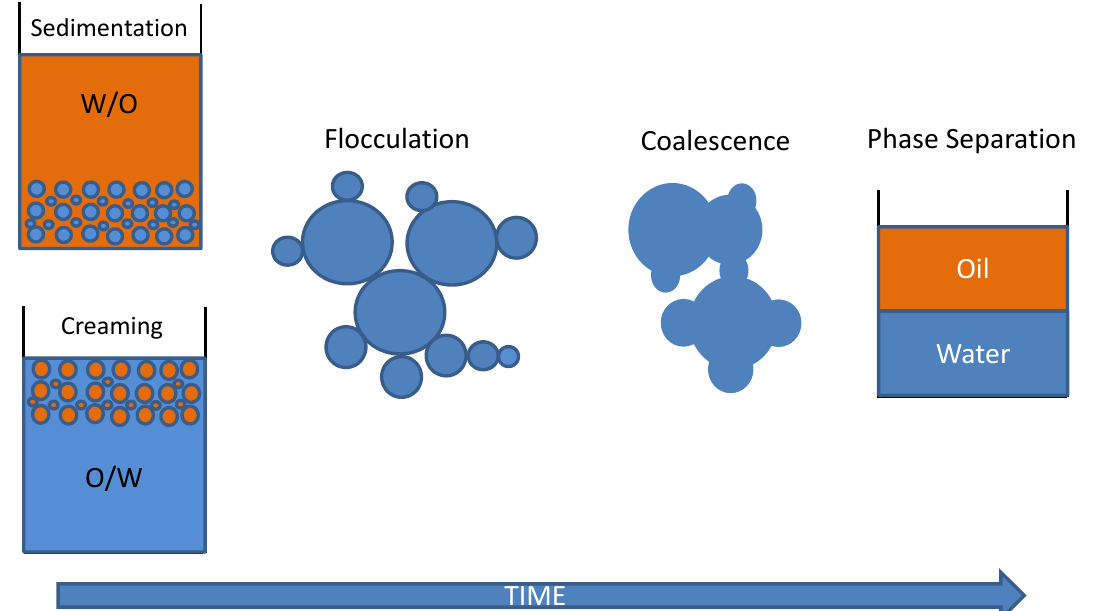
Figure 1. Steps toward phase separation in oil-water